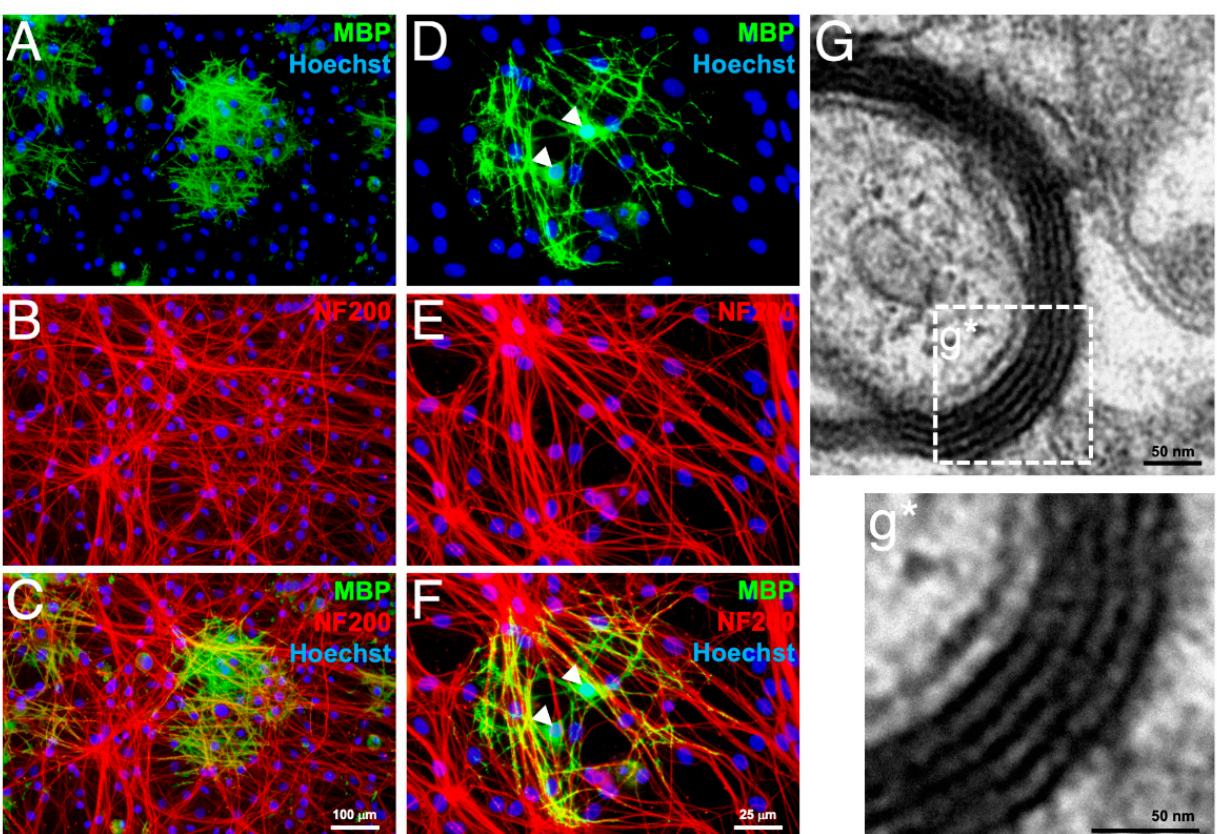
Figure 4. Maturation of OP-like cells into myelinating OLs in co-culture with neurons purified from embryonic day 15 rat dorsal root ganglia. After 2 weeks in co-culture, MBP-positive mature OLs ( A ) extended processes along NF200-positive axons ( B , merged image in C ). Higher magnification revealed individual OLs bearing multiple MBP-positive processes ( D – F ). OL cell bodies are indicated by white arrowheads ( D , F ). Transmission electron micrograph showing ultrastructure of compact myelin in a sample taken from an MBP-positive domain in the co-culture ( G , g* ). n = 4 independent prepara- tions.